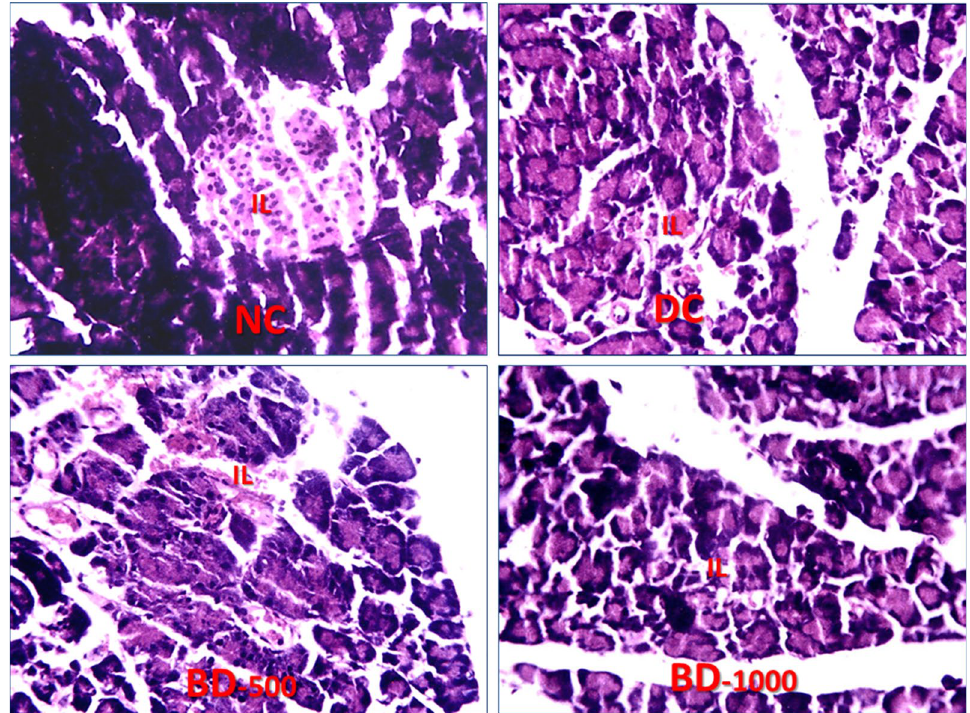
Fig. 3 Photomicrographs of sections of the pancreas from normal control (NC), diabetic control (DC), 500 mg/kg ASBE of B. dalzielii (BD-500) and 1000 mg/kg ASBE of B. dalzielii (BD-1000) groups. IL Islets of =